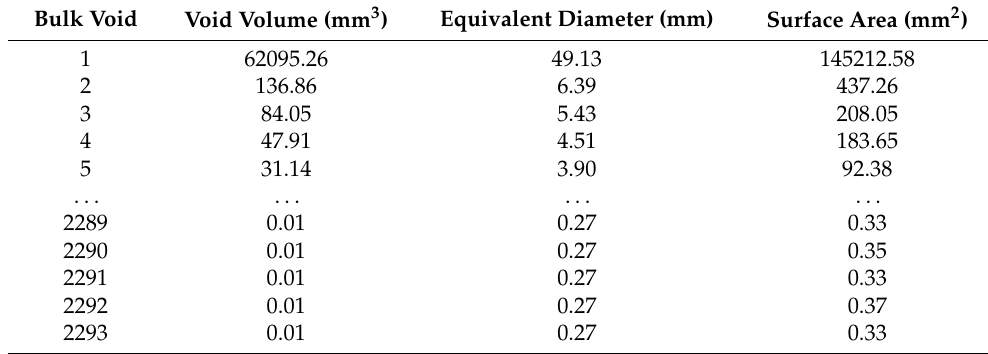
Table 10. Characteristic parameters of bulk voids in EPA-13 with 4.3% asphalt